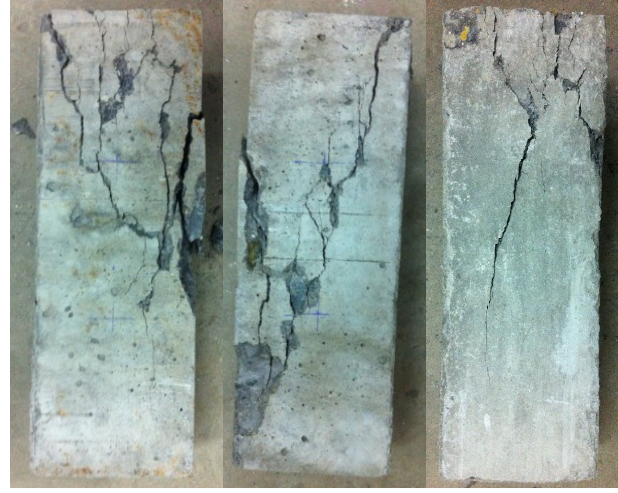
Figure 9. Photos of failed specimens.